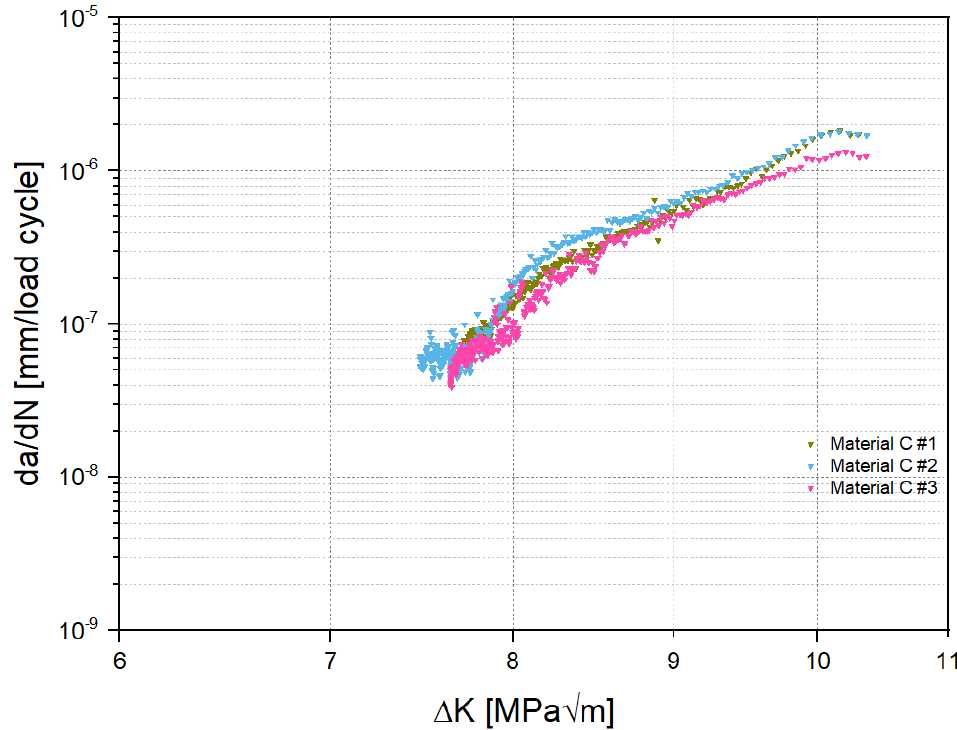
Figure 4. Fatigue crack growth curves for Material C; ECD: 9.99 mm; ALA: 29.48 mm; UTS: 1469 MPa; K IC : 116 MPa √ m—not valid.